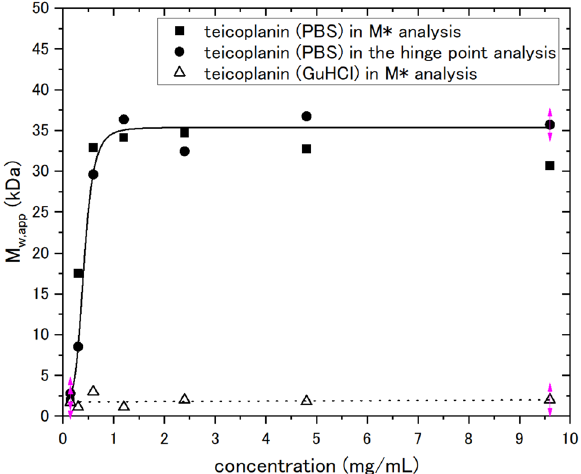
Figure 4. Change of weight average molar mass M w of teicoplanin with loading concentration derived from sedimentation equilibrium analysed by SEDFIT–MSTAR. Solid square symbols are molar masses M w,app obtained from the M* method. Solid round symbols are molar masses M w,app obtained from the hinge point method. Solid line is a standard French curve fit to the data. Open triangle symbols are molar masses M w,app of teicoplanin dissolved in 6 M GuHCl from the M*